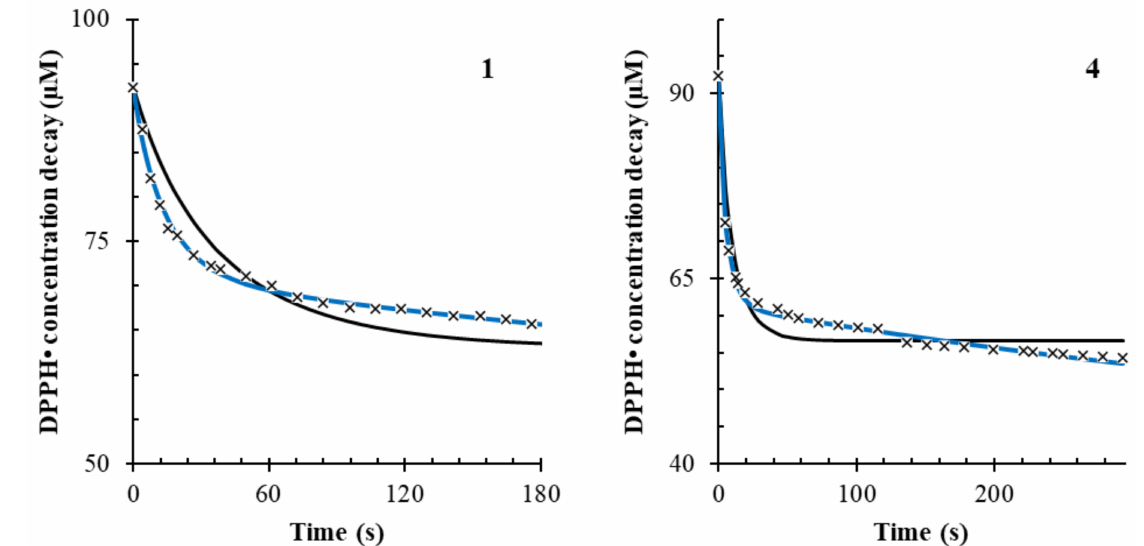
Figure 5. Fitting of the kinetic data for Moringa oleifera ( 1 ) and Harpagophytum procubens ( 4 ). The black solid line represents the fitting in the model without the side reaction, and the blue line represents the fitting in the model with the side reaction. The “x” points represent the data points for the recorded concentration decay of 100 µ M DPPH • .